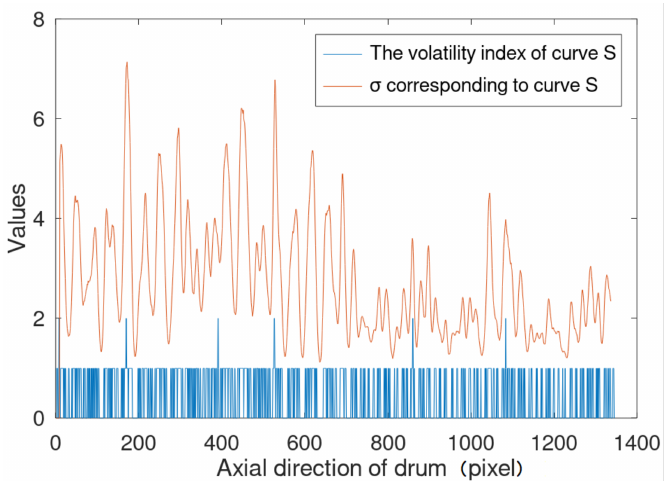
Figure 7. The volatility index of curve S and σ corresponding to curve S of frame